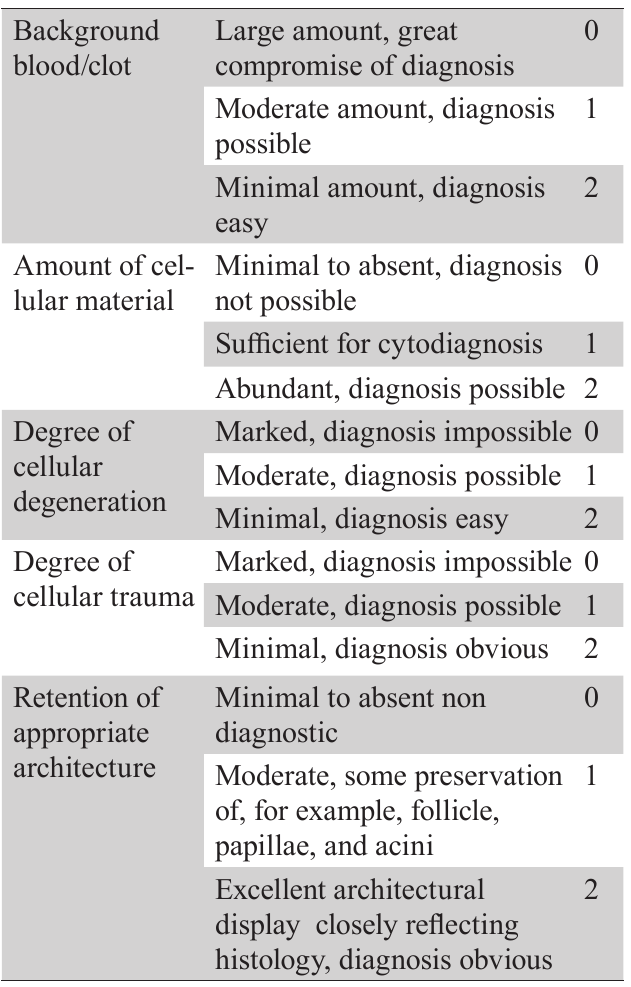
Table 1. The Mair et al. Scoring